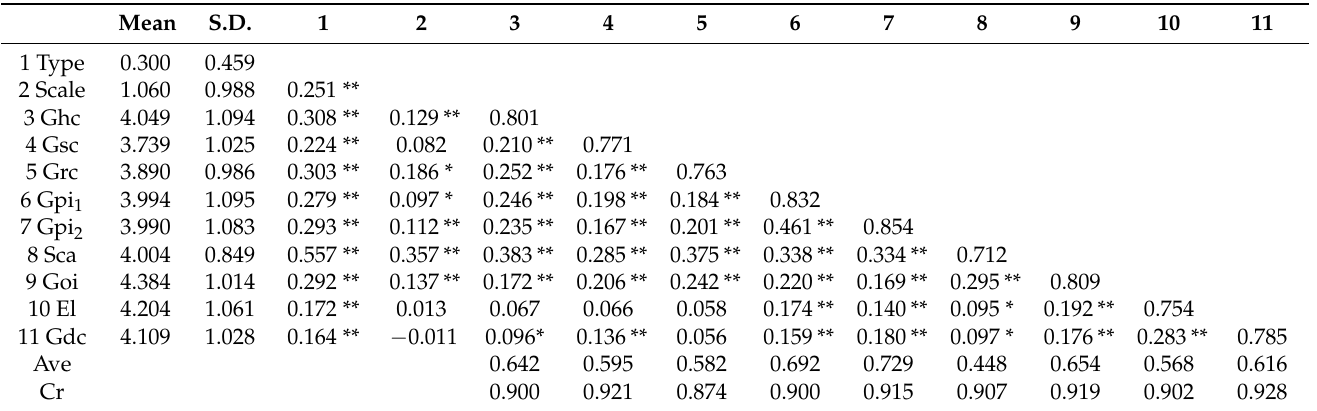
Table 3. Descriptive statistics correlation matrix and test of discriminant